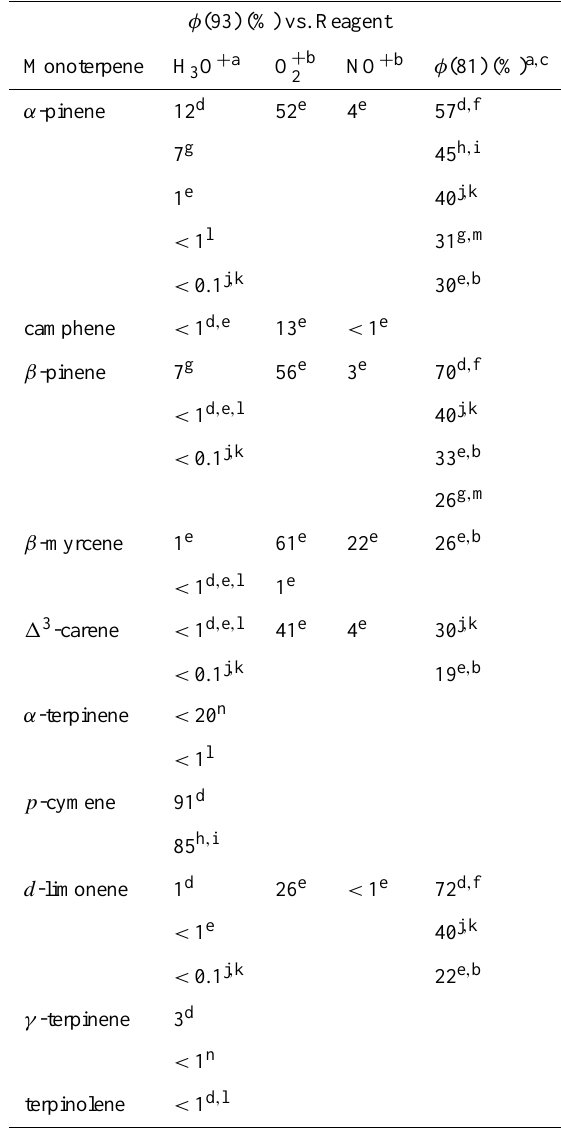
Table 5. Comparison of reported yields of m/z =93 fragment ions associated with analysis of monoterpenes by PTR-MS and SIFT- MS.